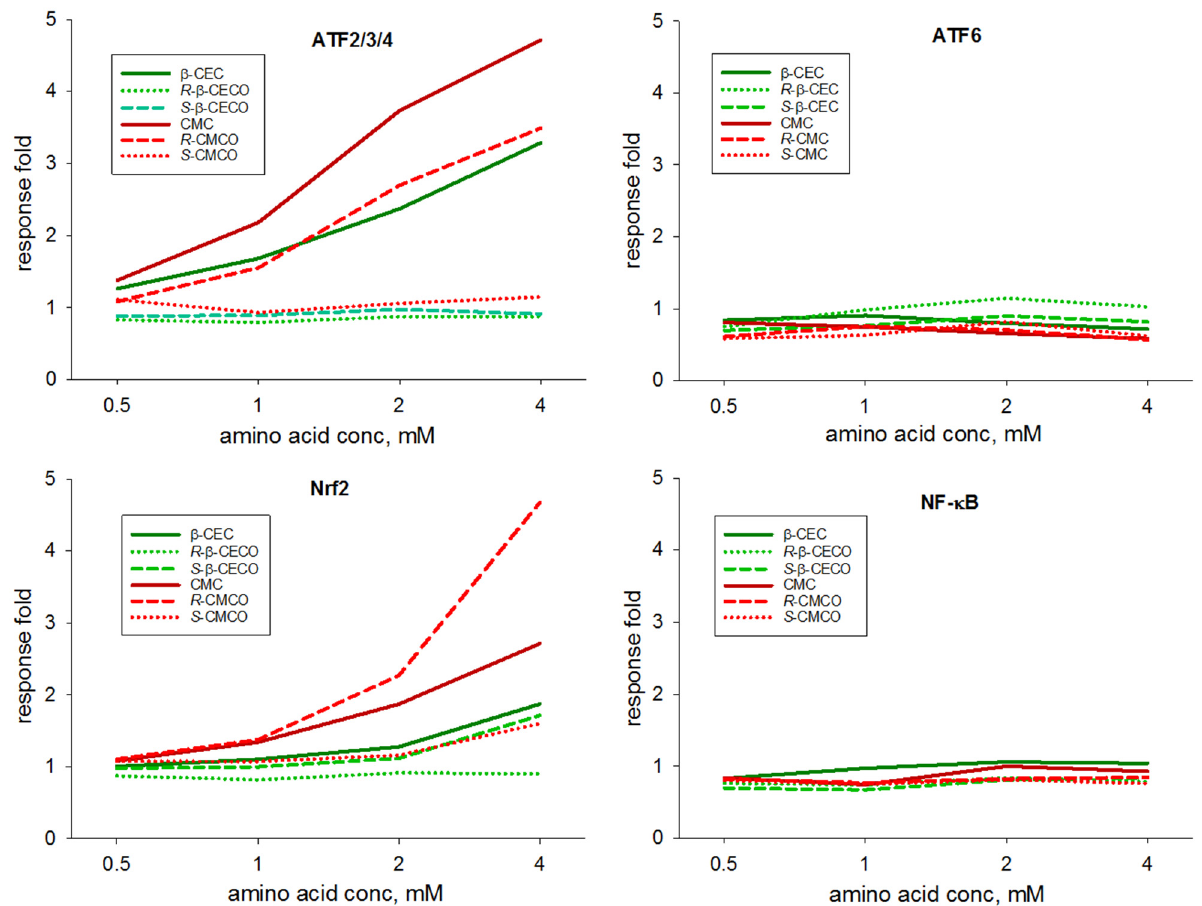
Figure 6. Transcriptional activation in NRK-52E cells treated with β -CEC, CMC, and the sulfoxides for 18 h. See extended Supplementary Materials Table S15 for viabilities and SDs, as well as data on activation of the transcription factors HIF-1, p53, and MTF-1.